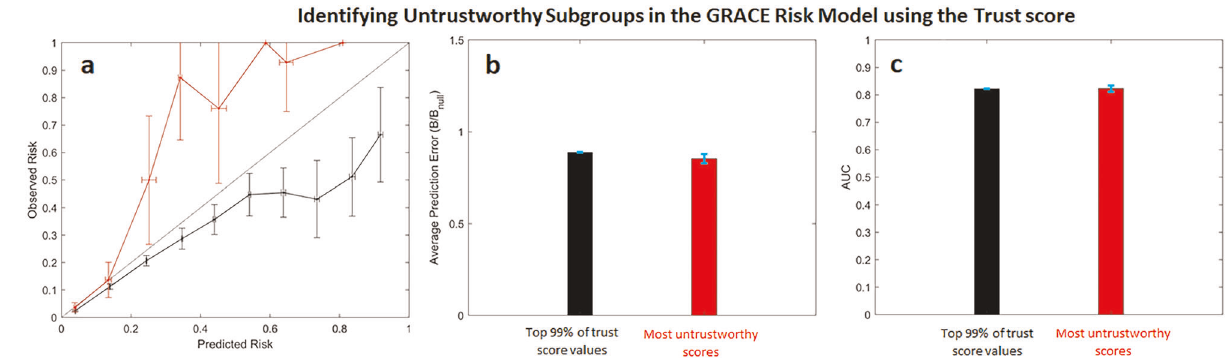
Fig. 4 Untrustworthy predictions in the GRACE risk model using the trust score. a Calibration curves, b normalized Brier scores, and c AUCs for the most untrustworthy predictions (red) and those that fall within the bottom 99% trust score values (black). Error bars are from 100 bootstrap splits and show one standard deviation ( a ) or one standard error of the mean ( b and c ). Error bars are truncated at 1.